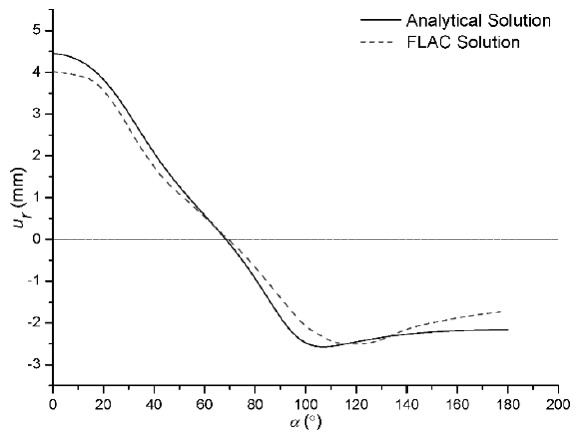
Figure 6. Radial displacement along the inner lining periphery.